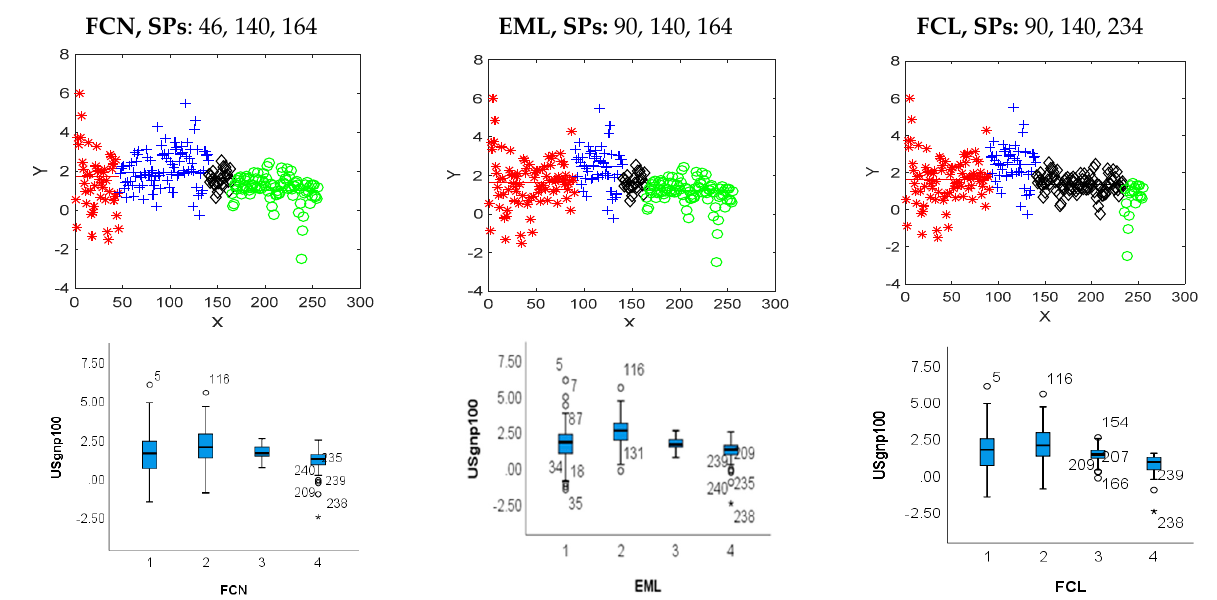
Figure 12. Plots and descriptive statistics of USGNP data.